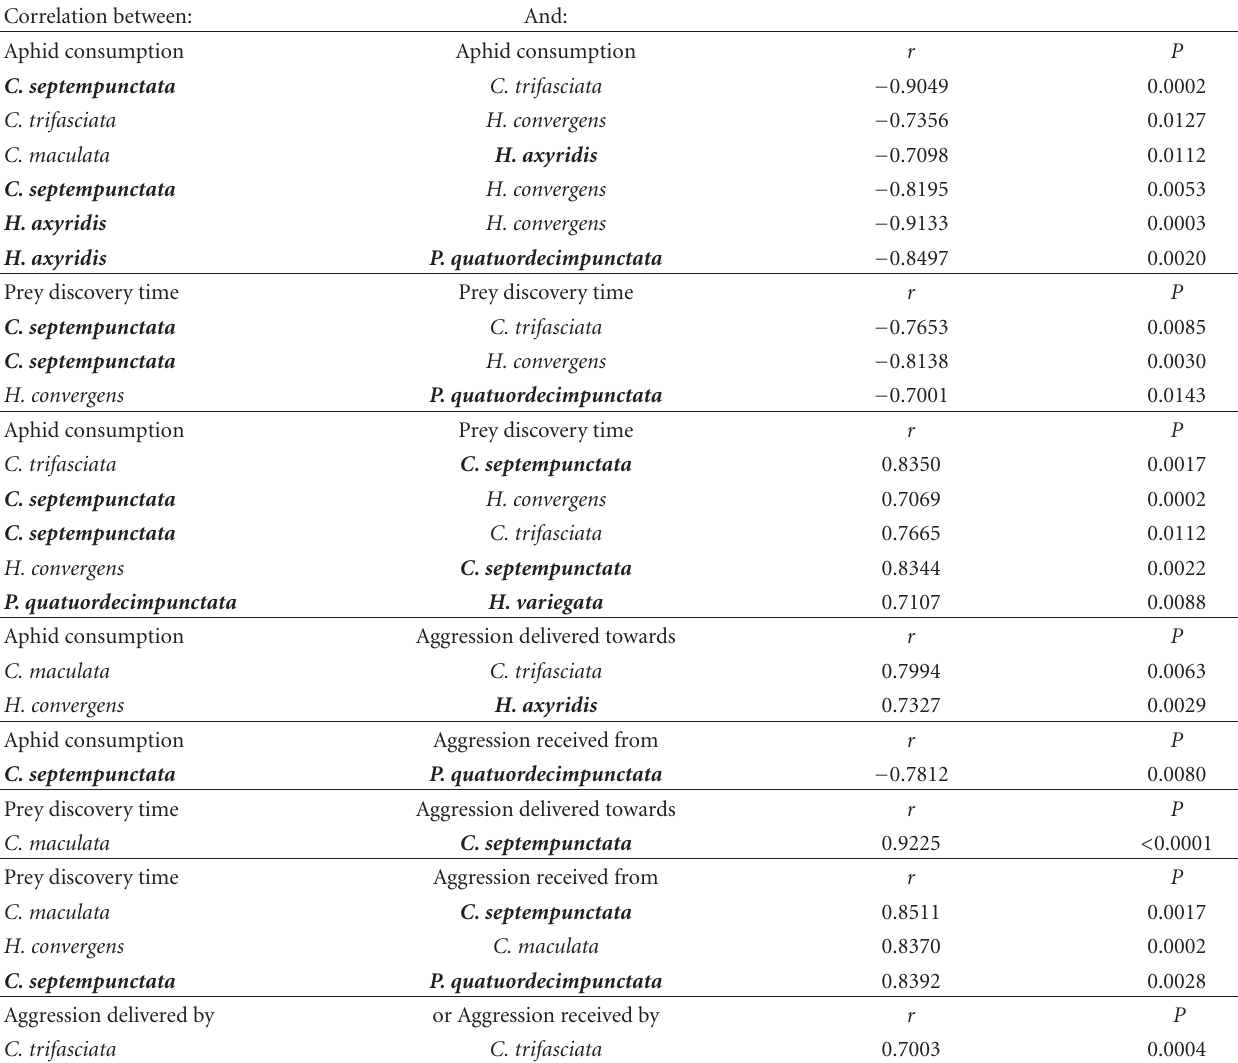
Table 6: Additional significant correlations between aphid consumption, prey discovery time, aggression delivered, and aggression received by lady beetles in trials ( N = 10). Nonnative species are printed in bold